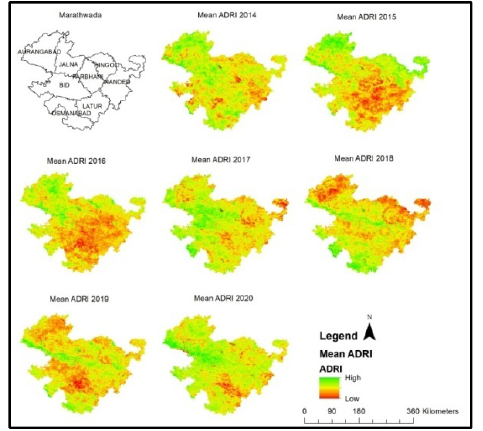
Figure 3: Annual mean ADRI over Marathwada for